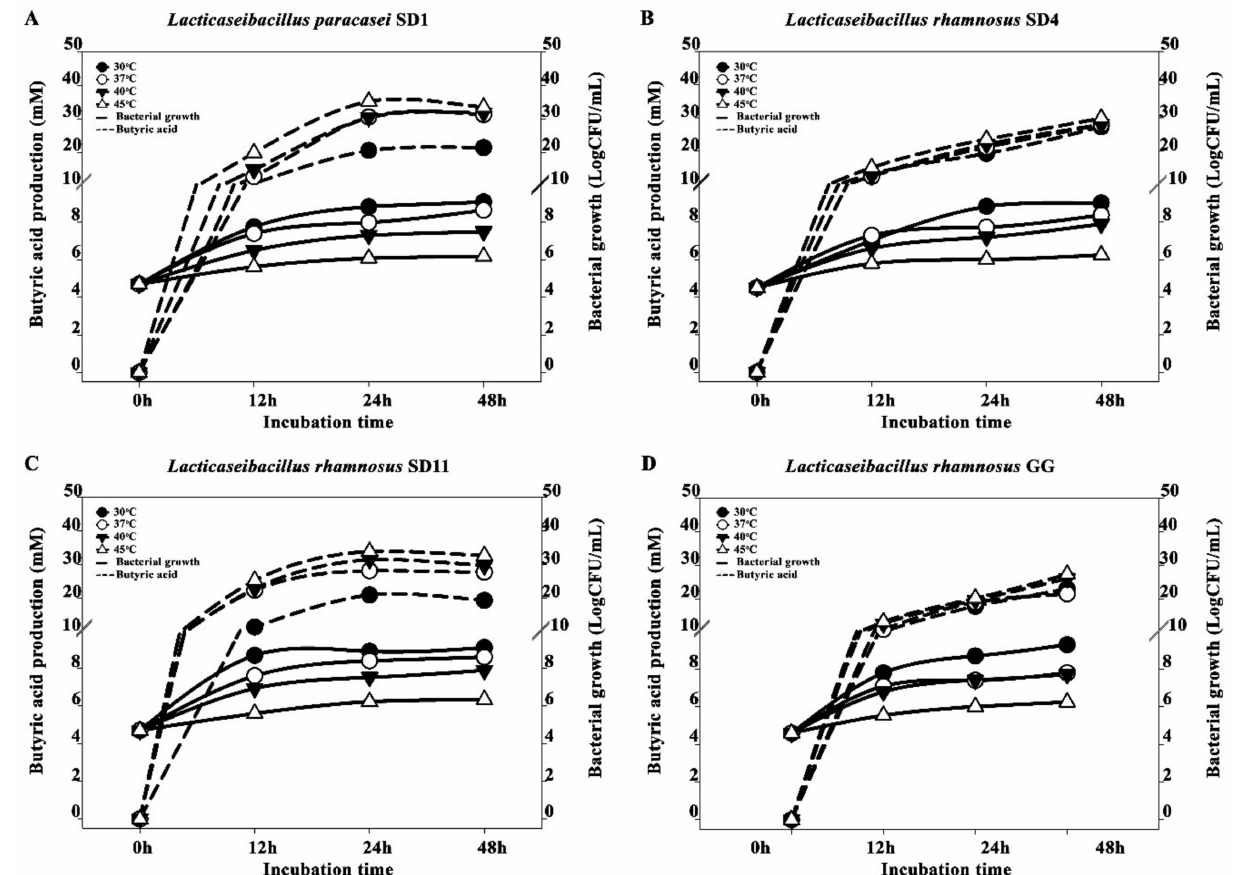
Figure 2. Butyric acid production and bacterial growth at different incubation times of various probiotic strains; ( A ) L. paracasei SD1, ( B ) L. rhamnosus SD4, ( C ) L. rhamnosus SD11, and ( D ) L. rhamnosus GG.